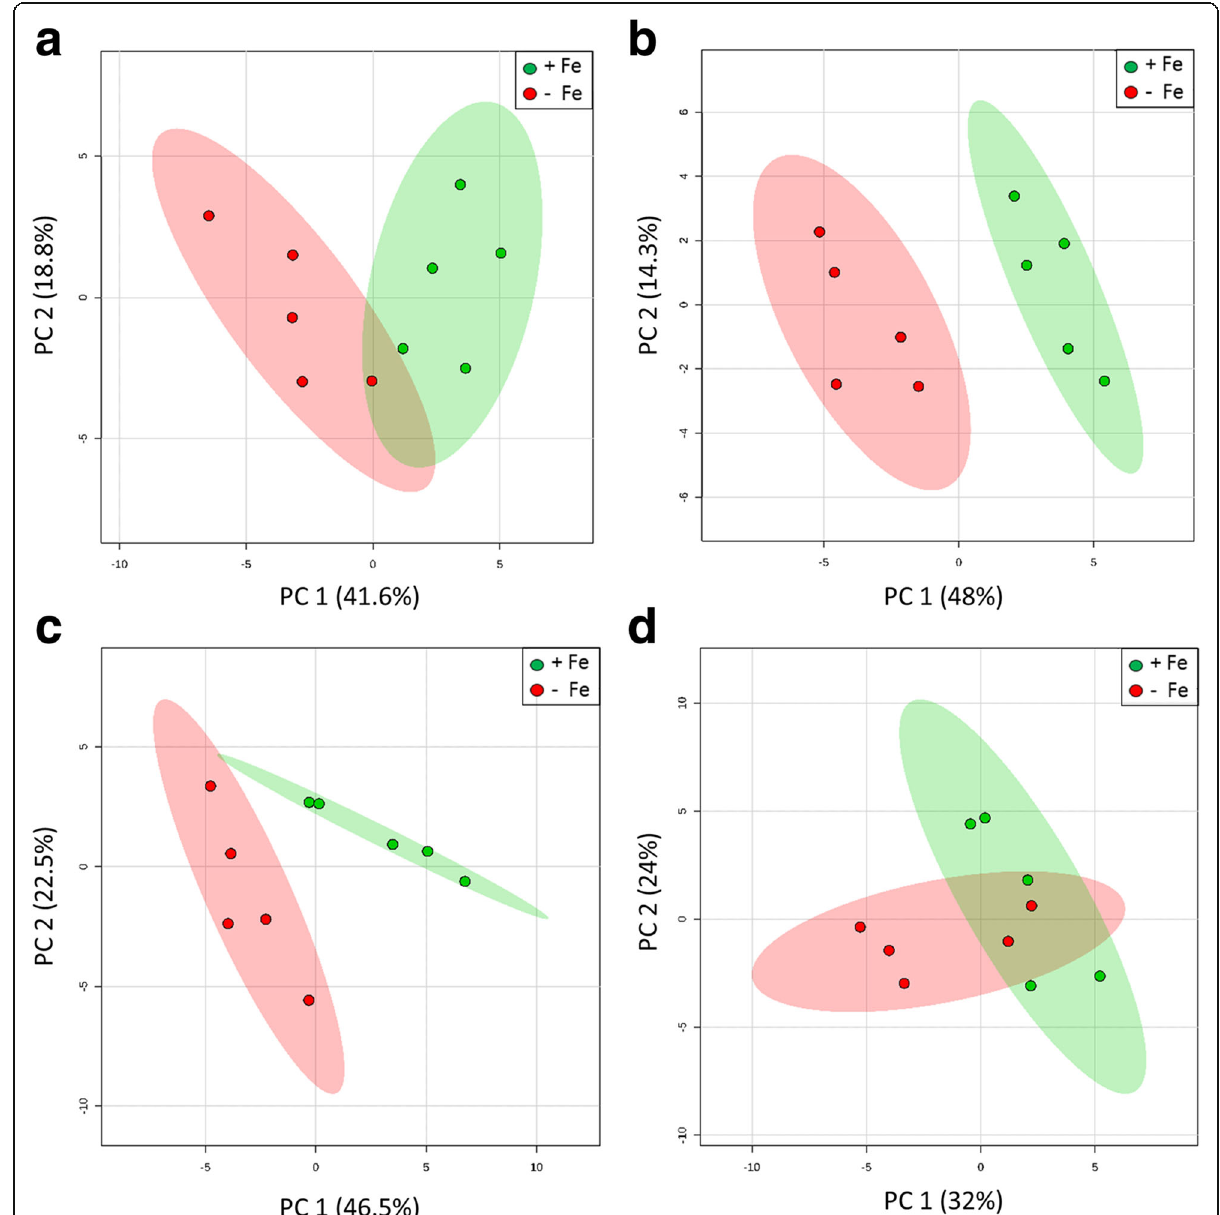
Fig. 4 Principal component analyses of root metabolite profiles from Fe-sufficient and Fe-deficient rice roots. Metabolite profiles from Fe-sufficient (+Fe: green ) and Fe-deficient ( − Fe: red ) rice roots were compared using 95% confidence regions within the collection times a 6:00 – 8:00, b 11:00 –